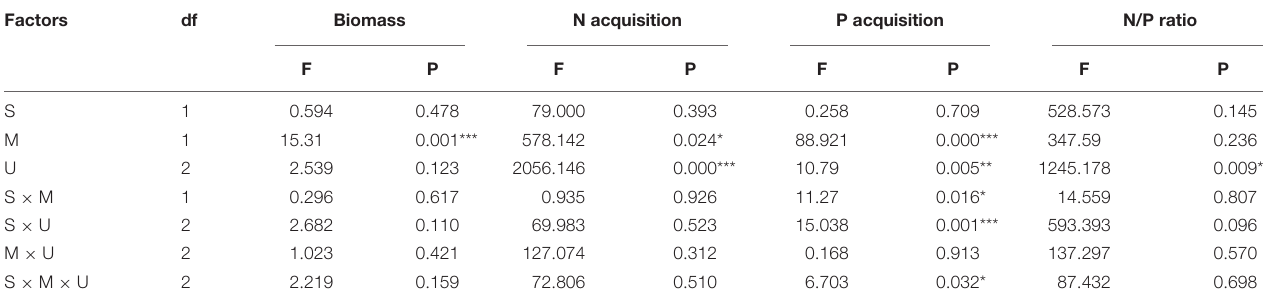
TABLE 6 | Three-Way ANOVAs for the effects of species ( Eupatorium adenophorum vs Artemisia annua ), mycorrhizal fungus (M + vs M − ) and nutrient utilization (Cu vs Su vs Nu) on biomass, N acquisition, P acquisition and N/P ratio. Factors df Biomass N acquisition P acquisition N/P